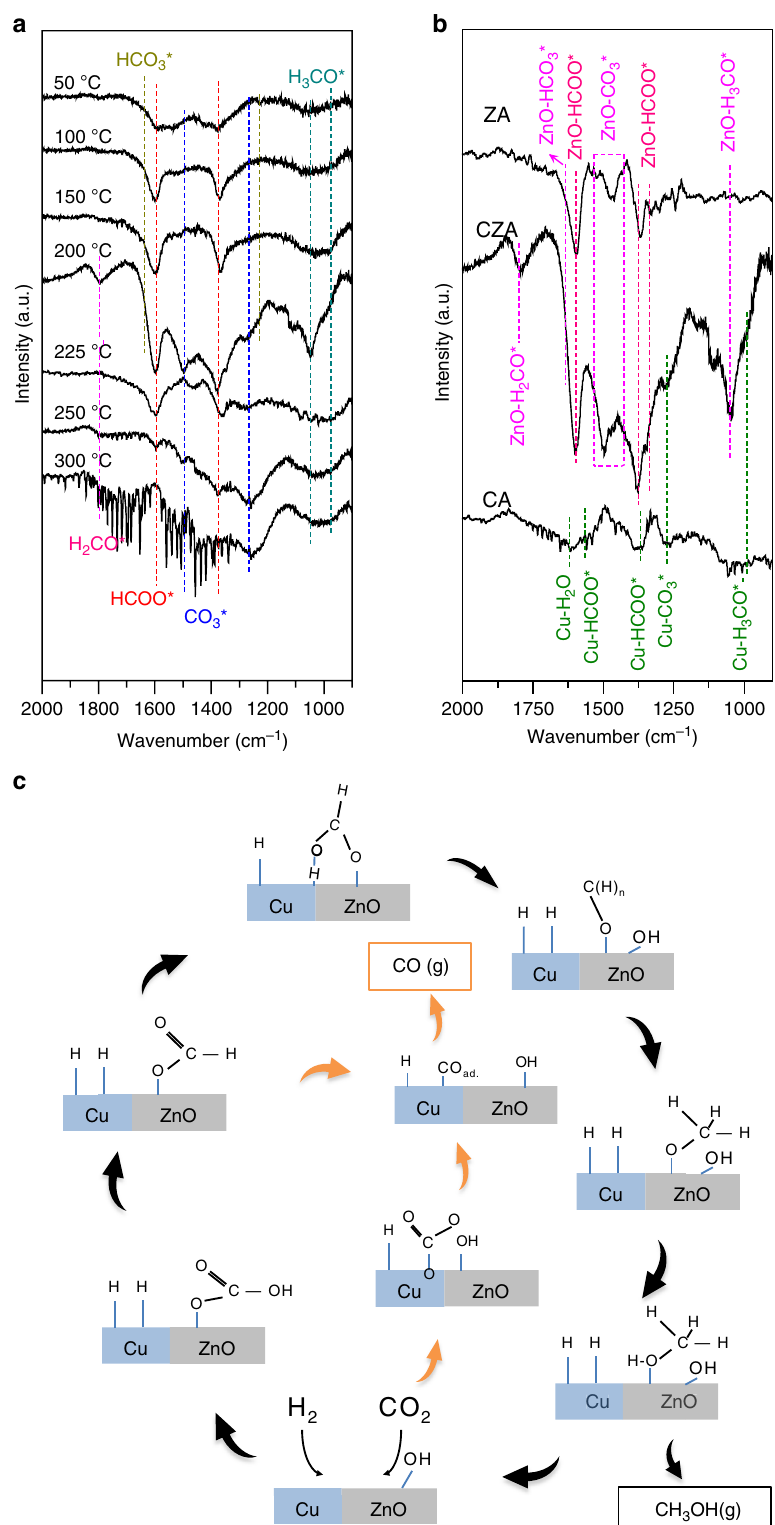
Fig. 2 Surface intermediates and reaction diagram. a Saturated DRIFTS spectra of different samples at 200 °C; b N 2 -purged DRIFTS spectra of CZA recorded at different temperatures (when stabilized at each temperature the catalyst was purged under N 2 for about 1.5 h to remove MeOH and H 2 O molecules), the formaldehyde (H 2 CO*), formate (HCOO*), carbonate (CO 3 *), bicarbonate (HCO 3 *), and methoxy (H 3 CO*) species are labelled with dotted lines; c Proposed methanol (black arrow) and CO production (orange arrow) pathways over Cu-ZnO